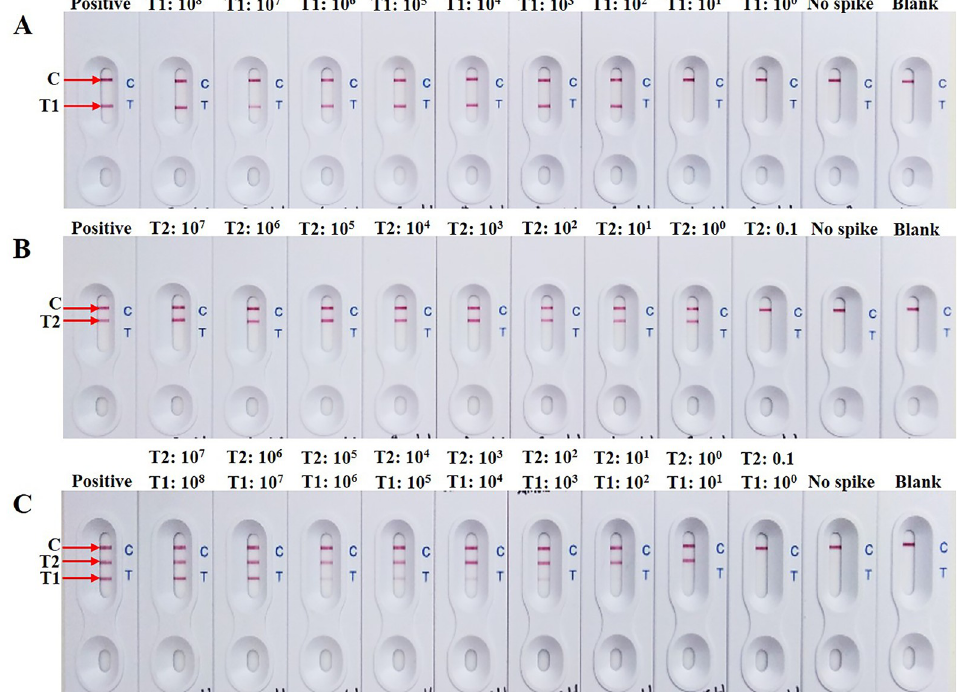
Fig 5. Lowest inoculated detection limit of s-LAMP-LFB assay for a single target detection of (A) C . jejuni or (B) S . Typhimurium in artificially contaminated raw chicken meat samples after 24 h enrichment. (C) Lowest inoculated detection limits of d-LAMP-LFB assay for simultaneous detection of both pathogens. Positive: positive control; No spike: non-spiked bacterial; Blank: blank control; C: control line; T1: test line 1 of C . jejuni ; T2: test line 2 of S .